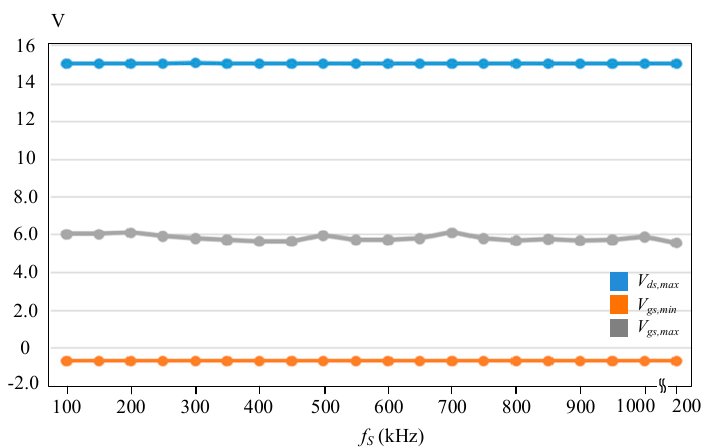
ds and V gs, . V ds,max was found to remain at approximately 15 V, V gs,min remained at